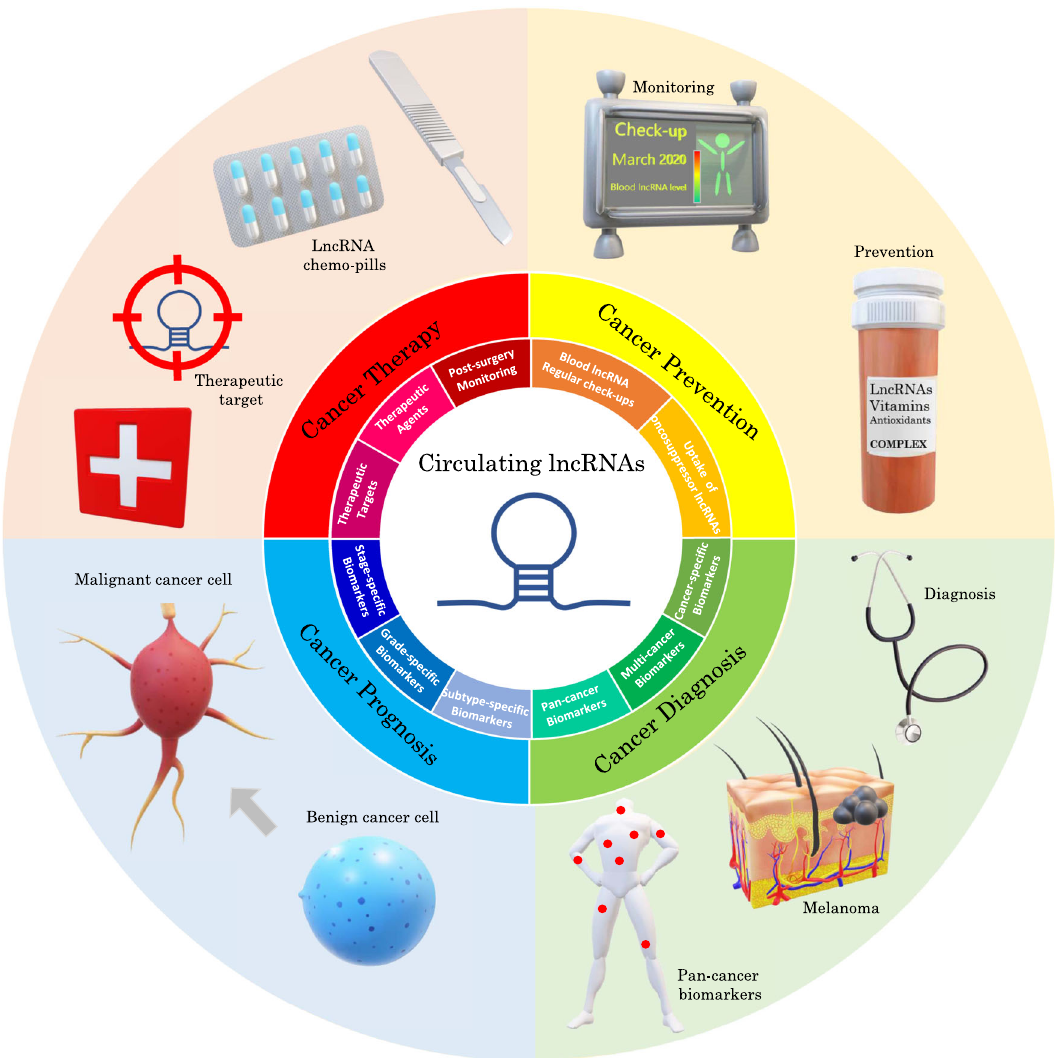
Fig. 1 Diagram summarizing the full panel of possible clinical applications that can be derived from the analysis of blood-based lncRNAs. Information indicated includes four main domains of applications (cancer prevention, cancer diagnosis, cancer prognosis, cancer treatment) and smaller subdomains referring to the domain of the same to observe similar patterns of blood lncRNA levels in cancers with the same embryological or anatomical origin as shown in Fig. 2a, b. However, there are some exceptions and circulating lincRNAs may not necessarily change upon tumorigenesis according to organ location or its embryological origin (e.g. endoderm, mesoderm, ectoderm). For instance, circulating lncRNAs associated with cancer from organs related to reproduc- tion (e.g. prostate, breast) may not follow such an anatomic/